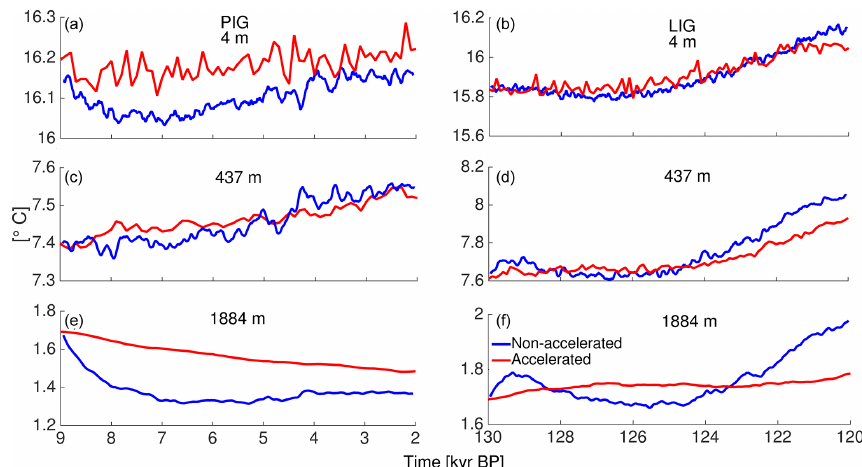
Figure 2. Evolution of global mean potential ocean temperature at various depths for the PIG (a, c, e) and the LIG (b, d, f) . Blue lines represent the non-accelerated simulations and red lines represent the accelerated simulations. All plots were created using the decadal mean values (referring to model years). In addition, a 10-point running average was applied to the decadal mean values of the non-accelerated simulations. Time series of the accelerated runs were mapped onto orbital time axes by linear interpolation, such that 10 model years represent 100 orbital years.